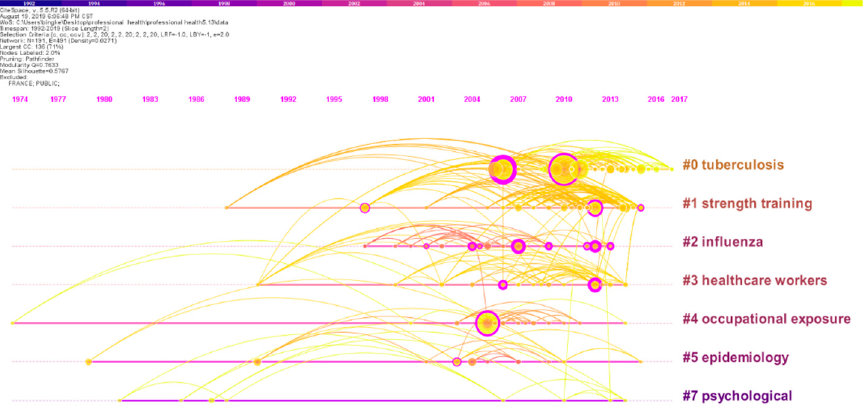
Figure 8. Document co-citation analysis clusters timeline visualization.